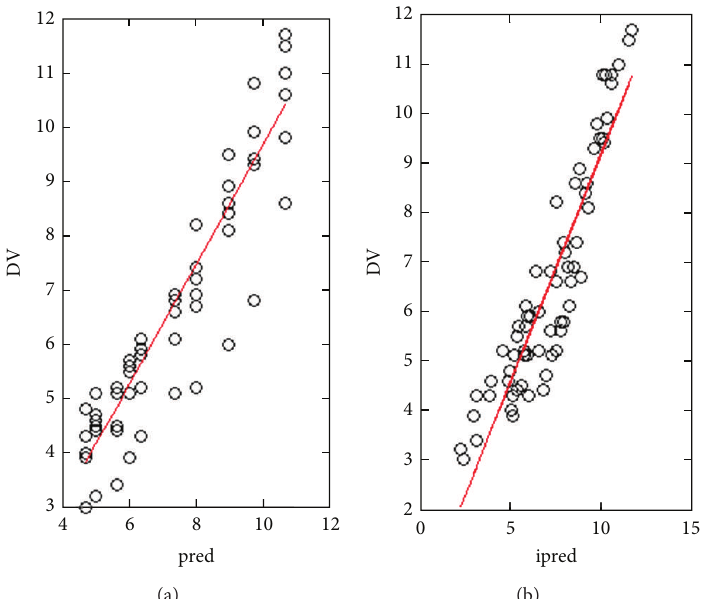
Figure 4: (a) Relationship between observed concentration and population predictions. (b) Relationship between observed concentration and individual